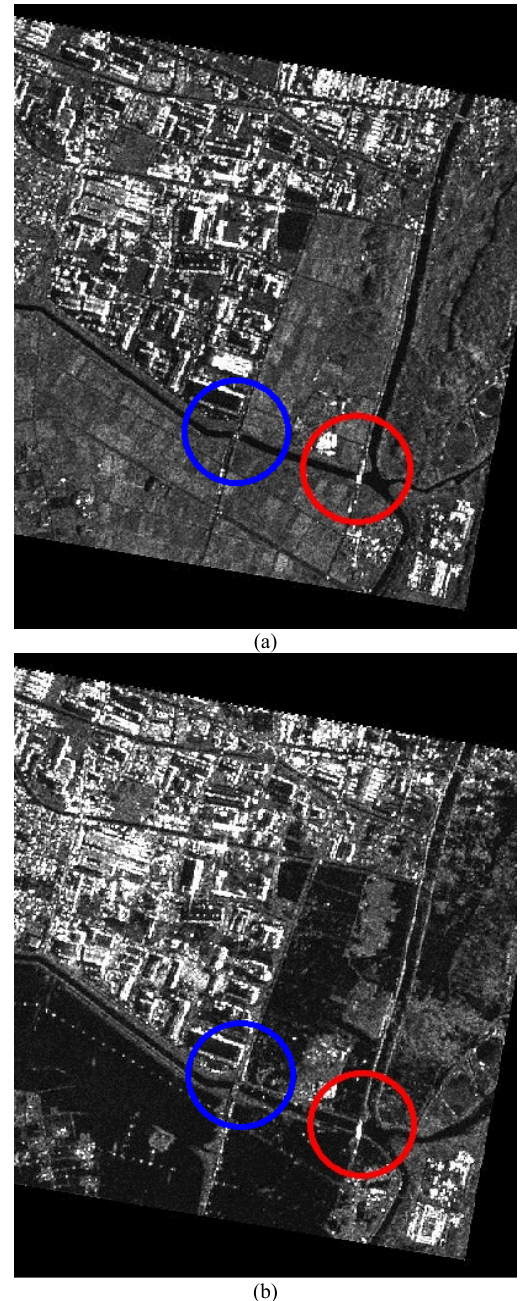
Figure 10. The pre-event (a) and post-event (b) TSX images within the study area (Figure 8). These two TSX images have been accurately co-registered and radiometrically calibrated. The blue and red circles indicate the locations of To and Fujisonetaishi Bridges respectively.